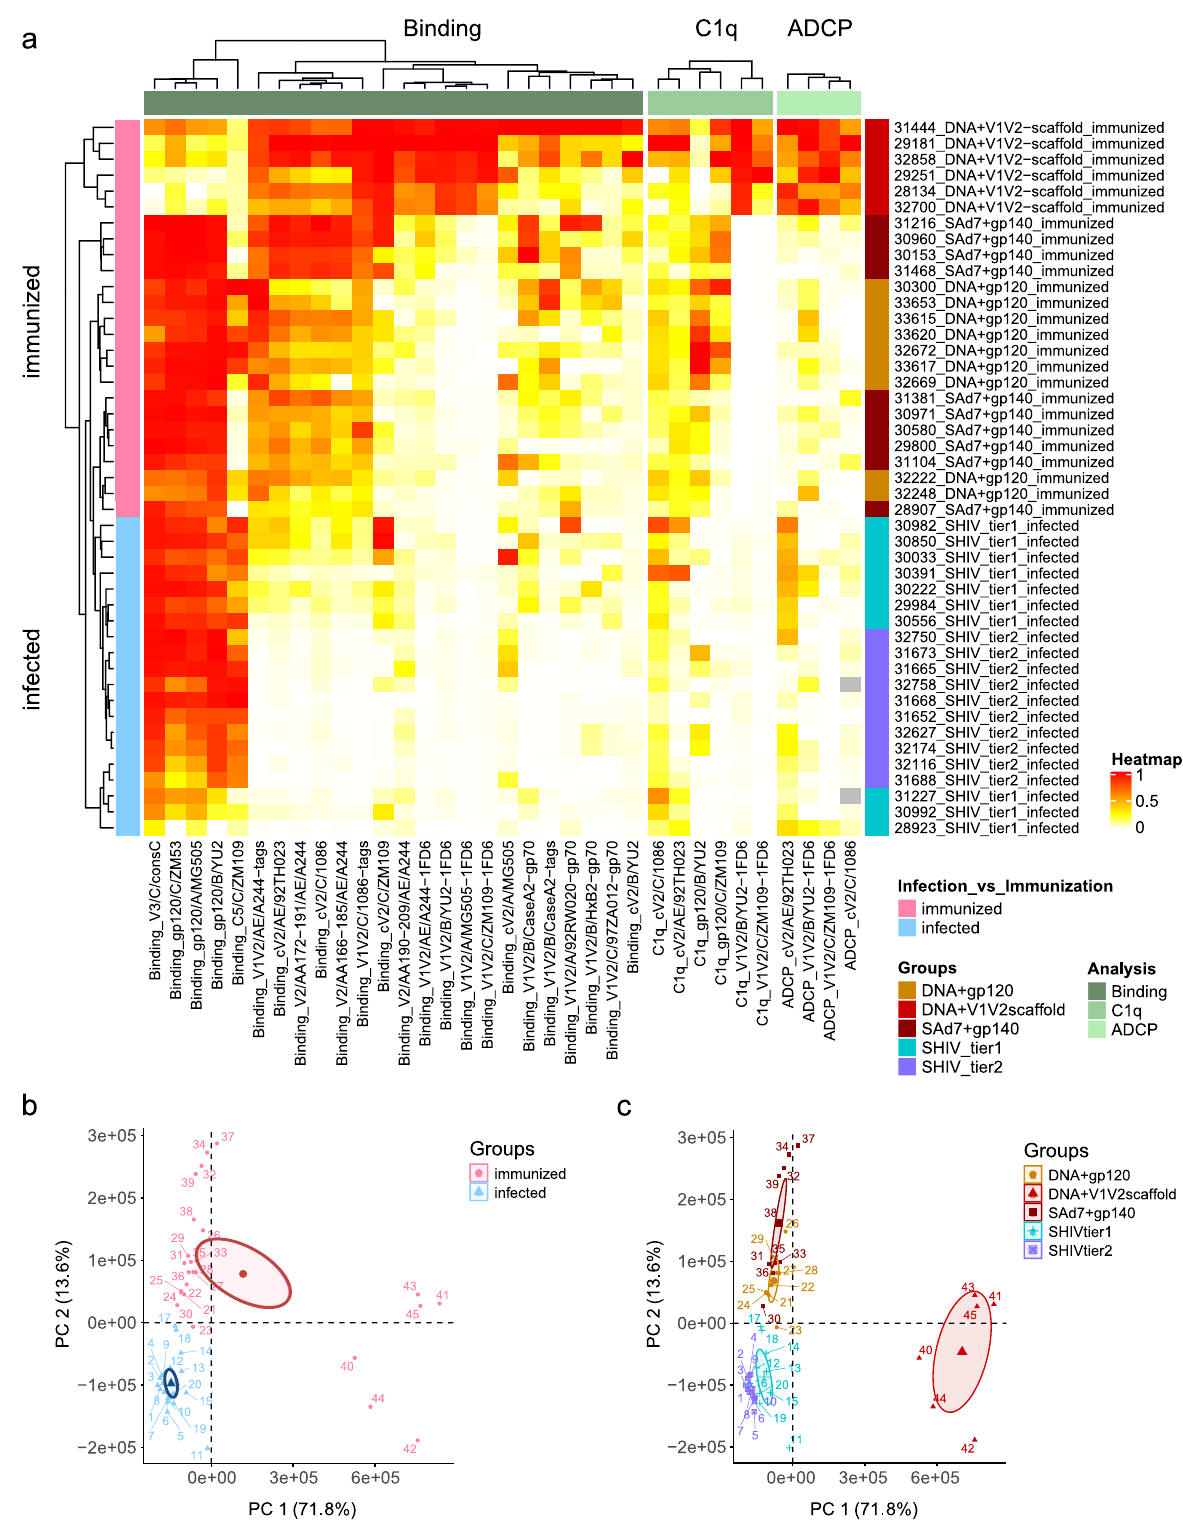
Fig. 5 Analysis of data from all 45 animals and all three types of assays. a Heatmap summarizing the humoral immune responses in immunized versus SHIV-infected NHPs. Immune responses shown in Figs. 3 and 4 and Supplementary Figs. S3 – S6 were normalized and color-coded as indicated in the heatmap legend. Columns represent immune responses grouped according to Ab binding, C1q binding, and ADCP and are clustered within each parameter (Ab binding, C1q binding, or ADCP) measured using the antigens shown at the bottom of the heatmap. Rows represent single animals, each identi fi ed by number, vaccine regimen, or SHIV-strain used for infection. The heatmap is shown with hierarchical clustering according to the three dendrograms at the top and the one to the left. b , c Principal component analyses were performed using all values from panel a which are colored in panel b as immunized (pink) versus infected (blue), or in panel c , according to NHP groups as indicated in the legend. The axes show the Principal Component 1 and 2 (PC 1 and PC 2). The ellipses indicate 95% con fi dence interval of the